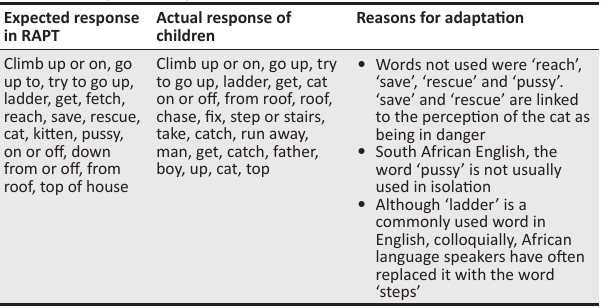
TABLE 5: Linguistic differences that may be misconstrued as part of a syntactic